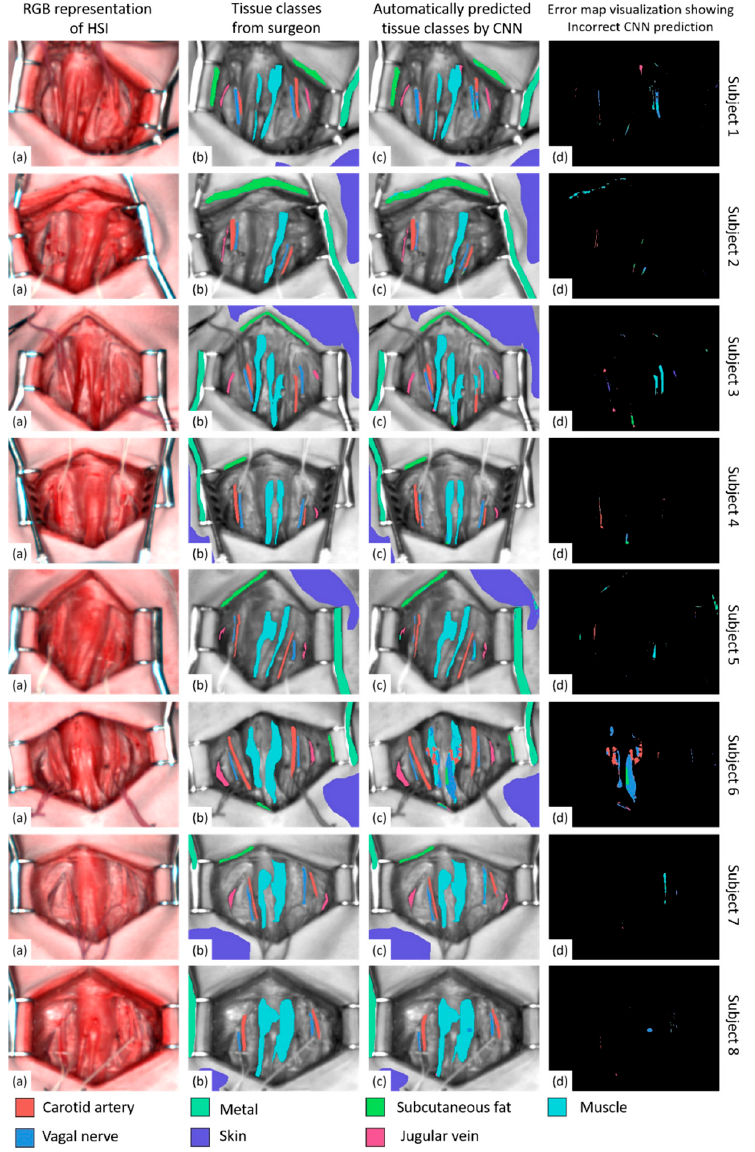
Figure 1. Automatic tissue recognition visualization: Visualization of automatic tissue recognition results from the CNN (convolutional neural network) model. In each row, we show images from subjects 1–8. From left to right, in columns, we show the RGB image simulated from HS ( a ), the ground truth classifications from the surgeon ( b ), the predicted classifications from the CNN ( c ) and the error map ( d ). Black pixels in the error map indicate a perfect classification (no error). Colored pixels indicate an incorrect classification, and the color provides the incorrect prediction.